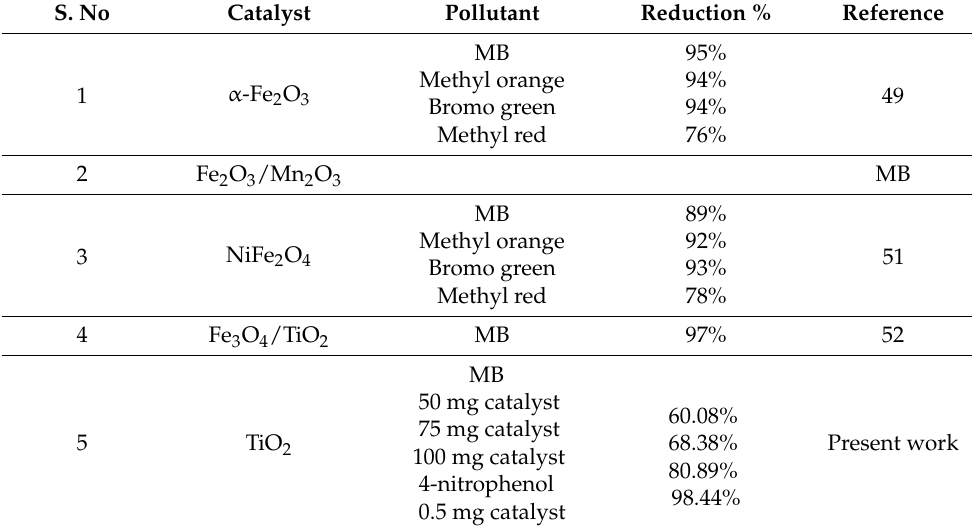
Table 1. Degradation reaction of MB using nanoparticles as an efficient